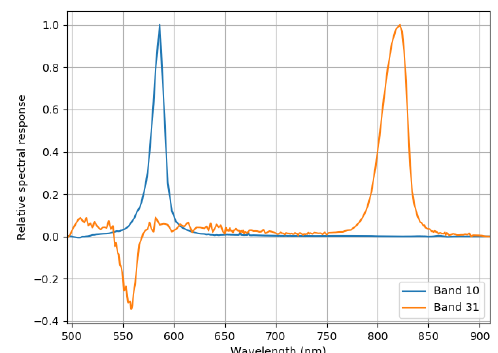
Figure 3. Example of full spectral response functions for bands 10 (centre wvl = 584.43 nm, FWHM = 16.64 nm) and 31 (centre wvl = 816.73 nm, FWHM = 27.97 nm). Curves are scaled so that the maximum value is 1. Band wise linear parameters a and b to adjust L Man to SI-traceable